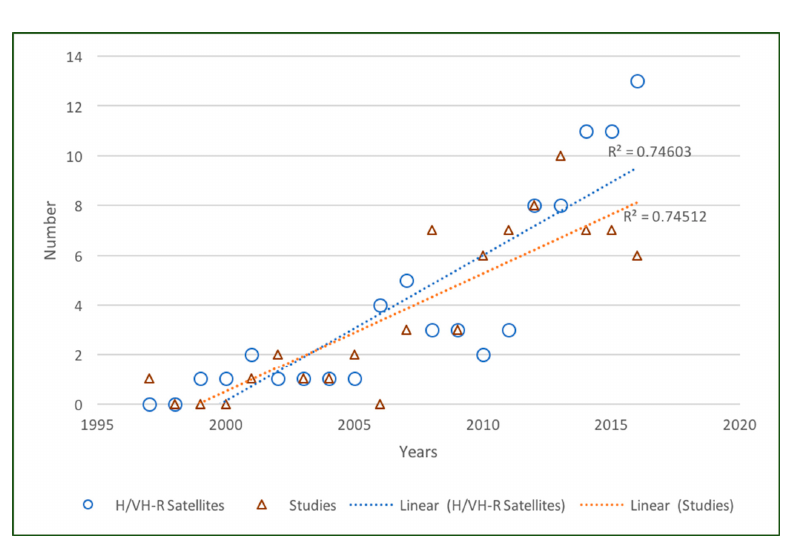
Figure 1. Research using H/VH-R imagery to study slums, 1997–2016 (Data on number of satellite updated after [15,140]).